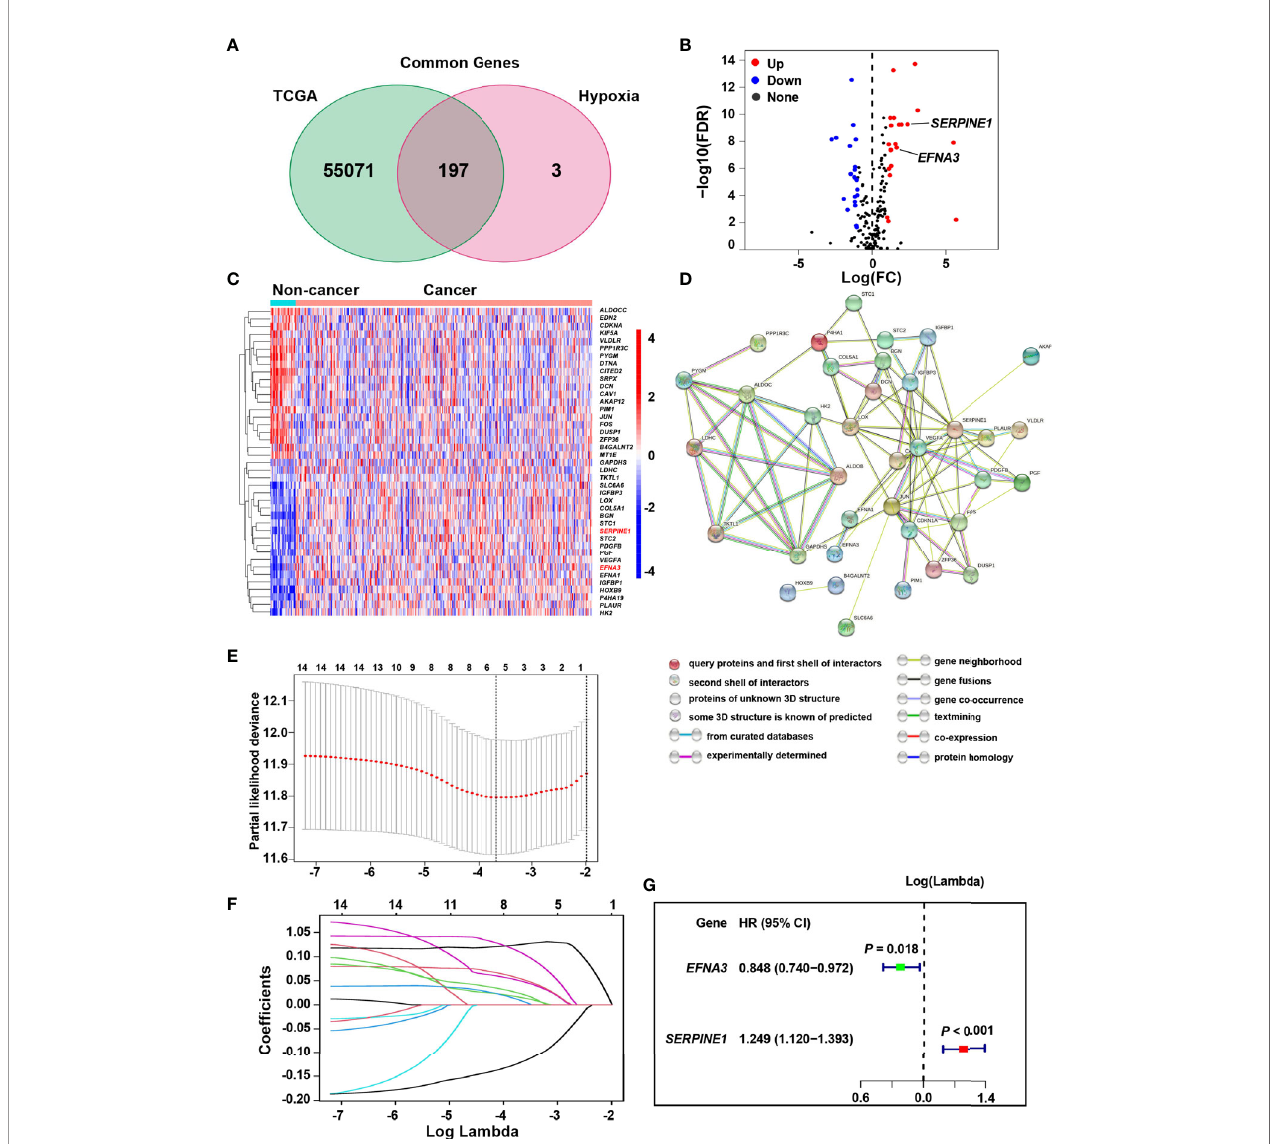
FIGURE 1 | Identi fi cation of the hypoxia risk signature. (A) The Venn diagram shows the hypoxia-related genes in TCGA. (B) The Volcano plot for differentially expressed genes (DEGs) in cancer and non-cancer tissues. (C) The heatmap plot for DEGs in cancer and non-cancer tissues. (D) The PPI network visualizes the interaction between these DEGs. (E, F) The LASSO method identi fi ed fi ve genes associated with prognosis. (G) The Cox proportional hazards analysis identi fi ed the hypoxia risk